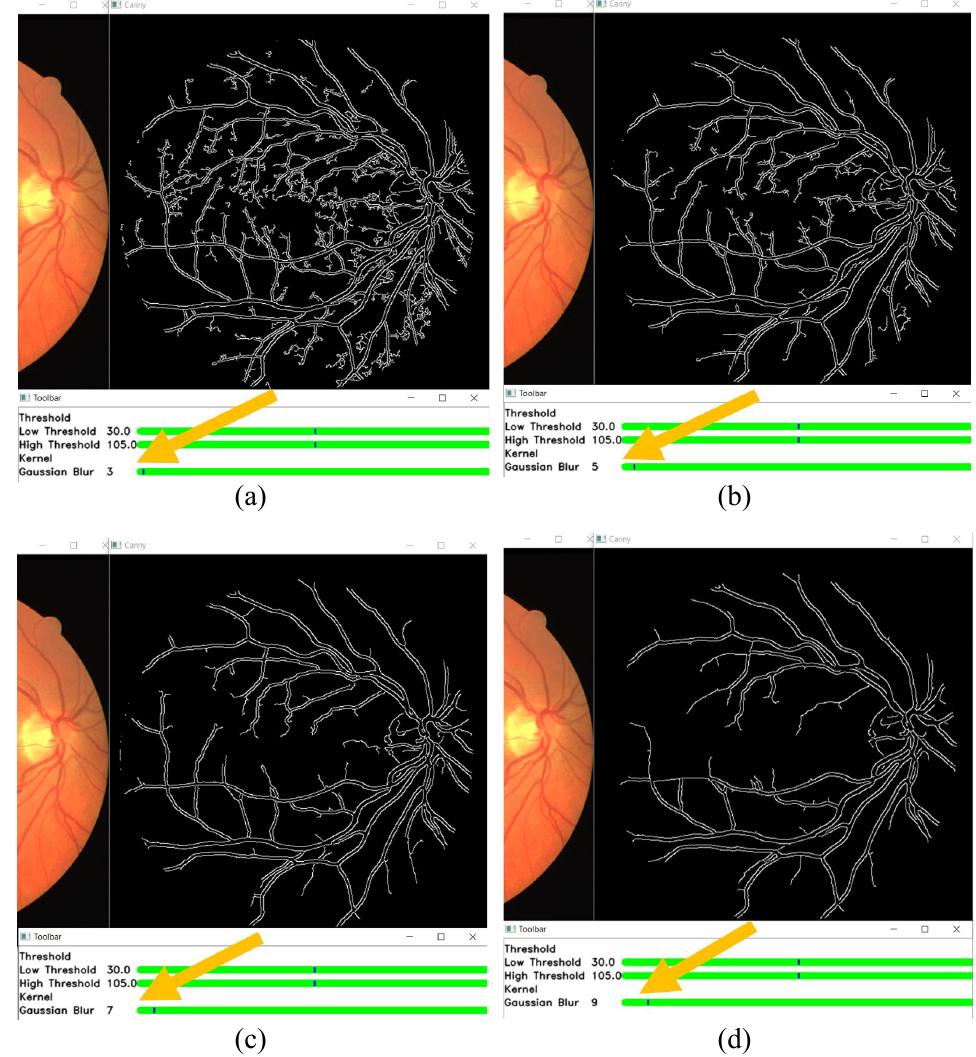
Figure 12. Edges detected by using a Gaussian filter of size ( a ) 3 × 3 pixels, ( b ) 5 × 5 pixels, ( c ) 7 × 7 pixels, and ( d ) 9 × 9